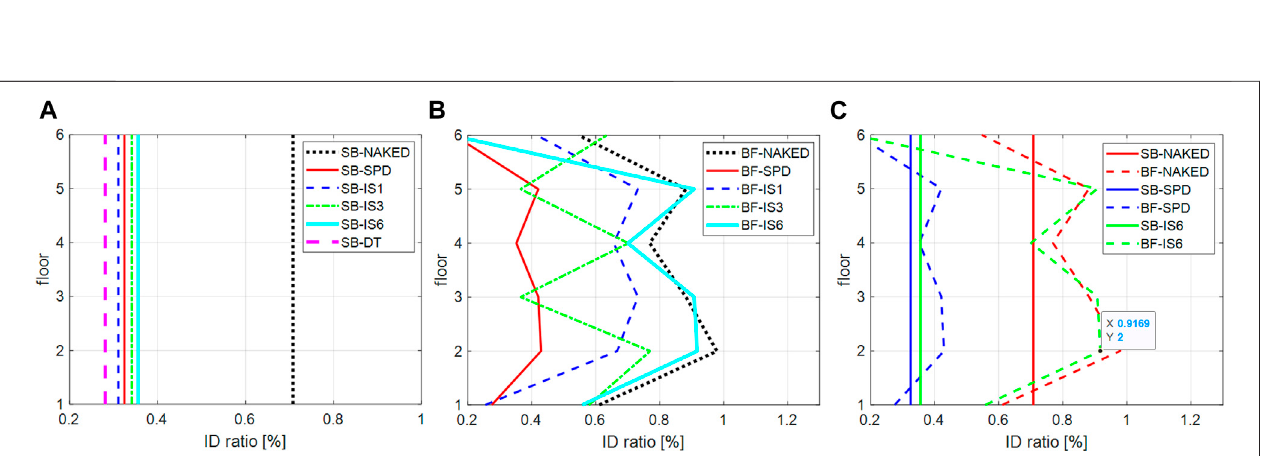
FIGURE 8 | (A) ID for the SB systems. (B) ID for the BF systems. (C) Comparison of ID for the SB and BF systems.